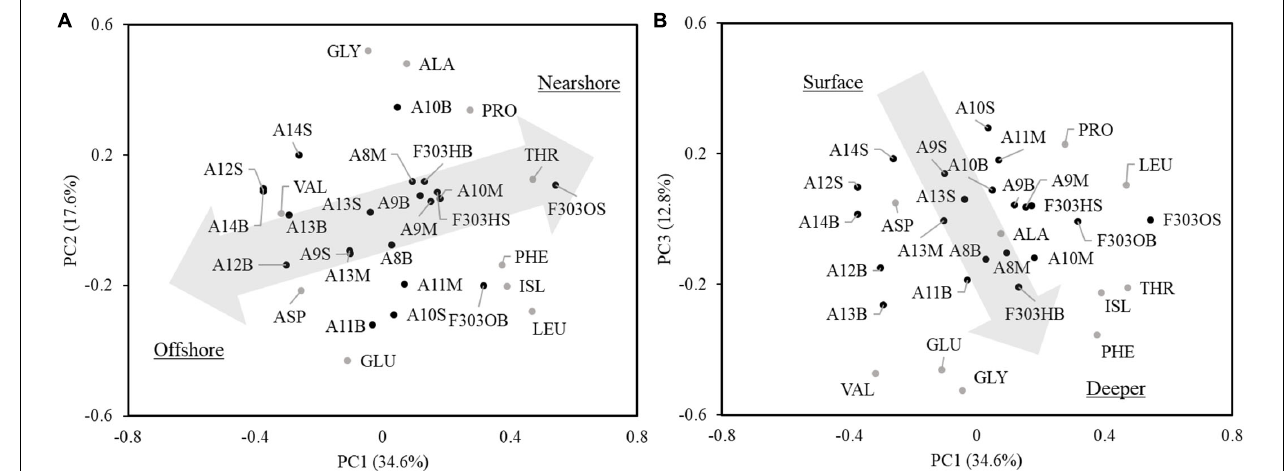
FIGURE 6 | Principal component analysis of amino acid δ 13 C values in particles from transect A and station F303. The site scores were divided by eight for better visualization. The first three principal components account for 34.6, 17.6, and 12.8% of the variations. PC1 and PC2 (A) clusters the samples into offshore (bottom left) and nearshore (upper right) samples. PC1 and PC3 (B) clusters the samples into surface samples (upper) and samples in depth (bottom). Letters behind the station represent depth of the sample, the “S”, “M,” and “B” indicates surface, middle, and bottom water, respectively. Station F303H and F303O are the two visits to station F303 before and after the Tropical Storm Son-Tinh,